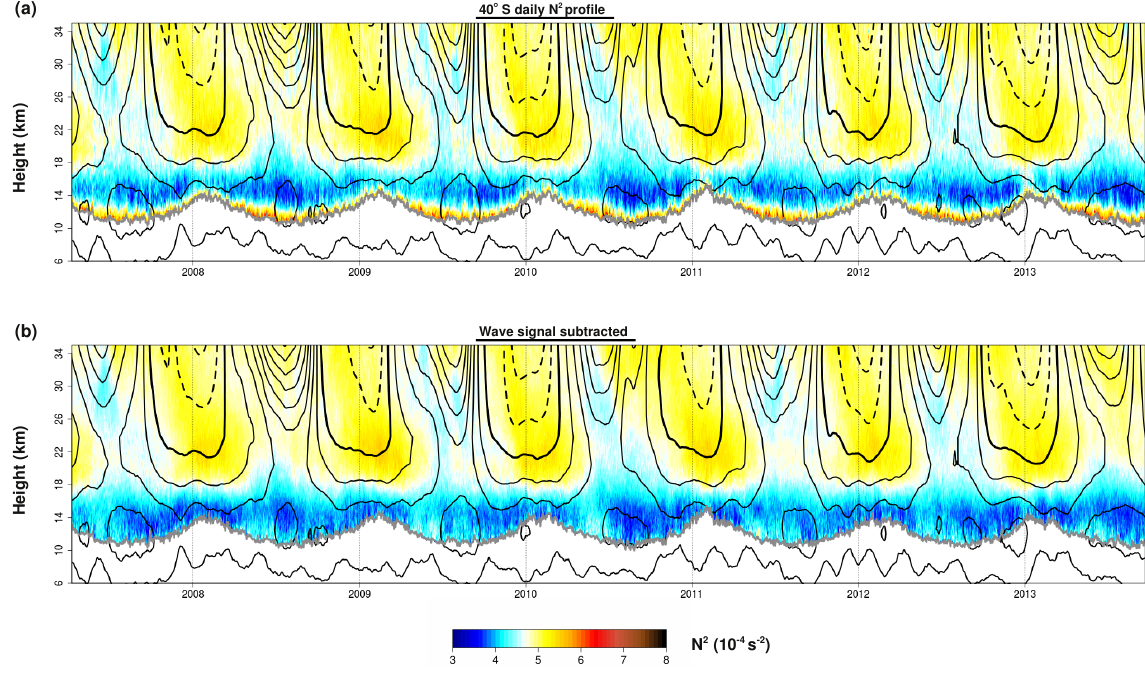
Figure A2. As in Fig. 5, but for 40 ◦